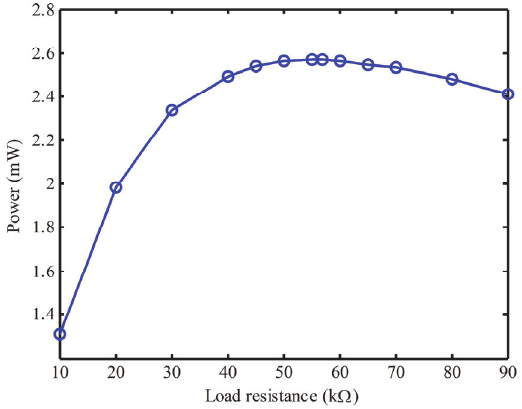
Figure 10. Output power with different load resistances for the MPEH.